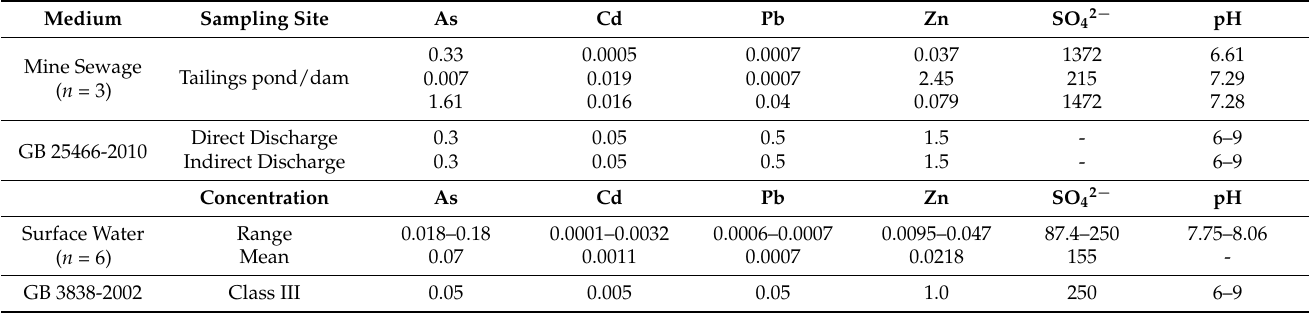
Table 2. Geochemical properties of water in the study area (mg/L).